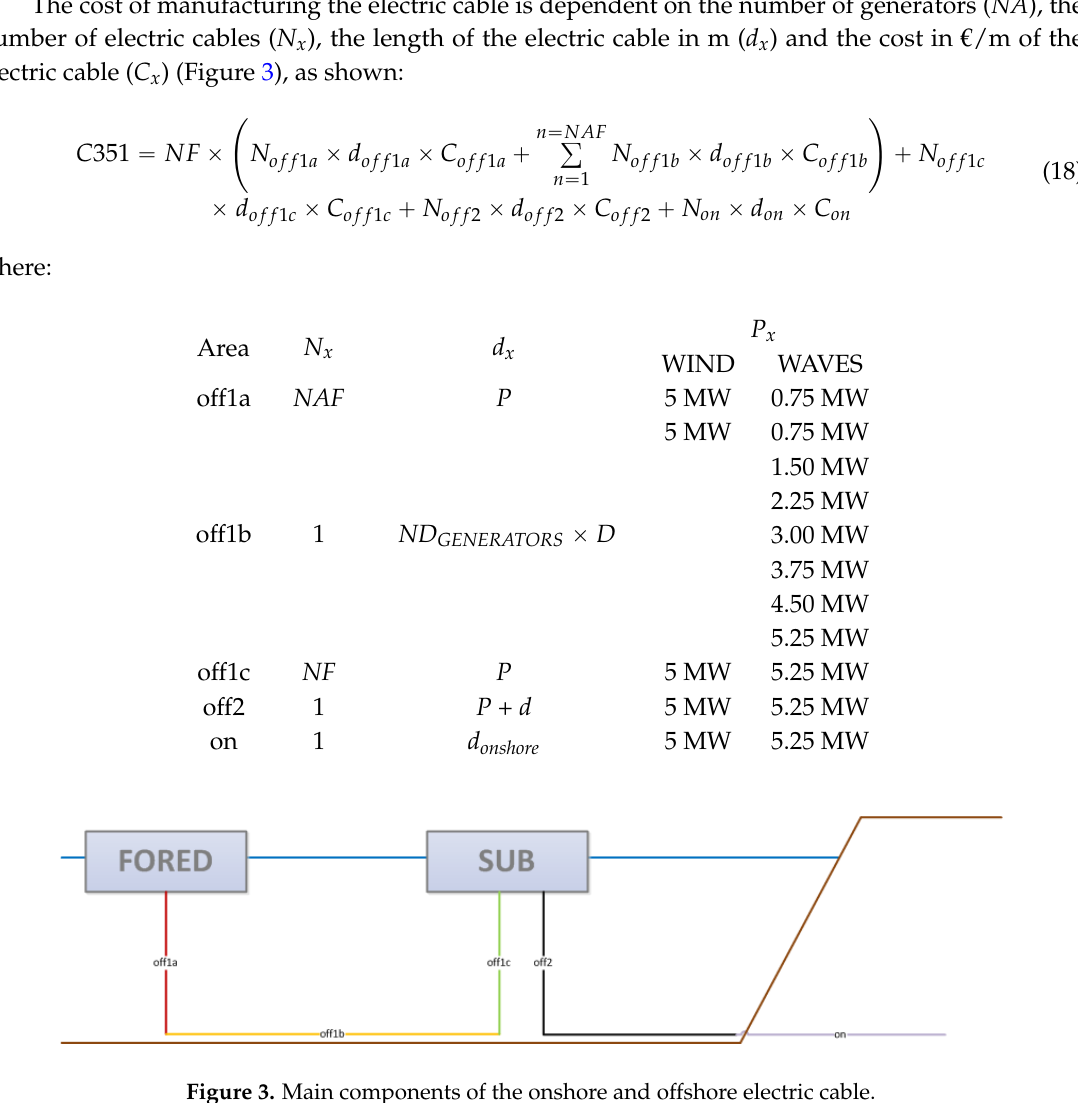
Figure 3. Main components of the onshore and offshore electric cable.